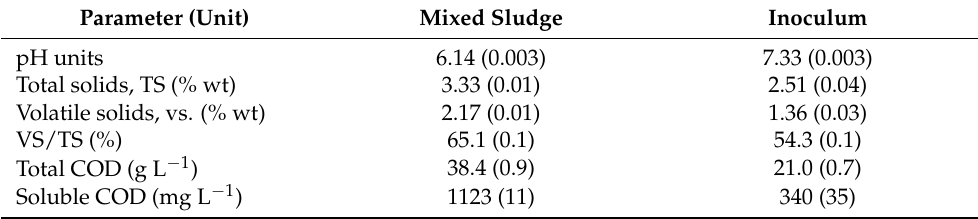
Table 1. Characteristics of mixed sludge (substrate) and anaerobic digestate (inoculum) (standard errors between